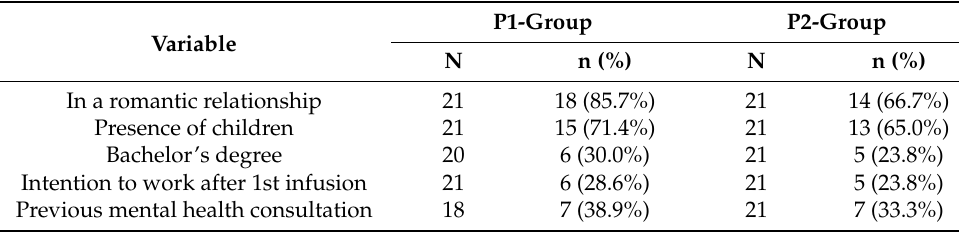
Table 1. Descriptive statistics of sociodemographic variables in the P1 and the P2 groups.